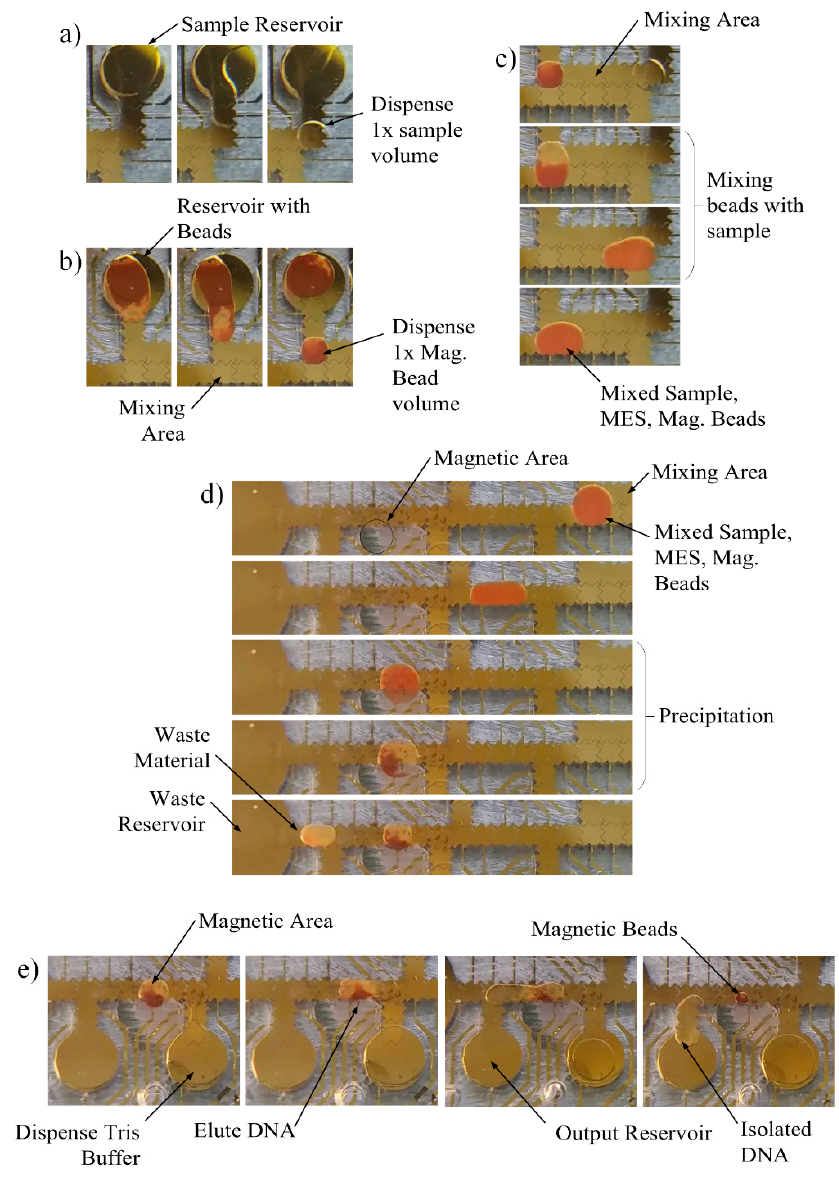
Figure 17. Bead method DNA isolation sequences. ( a ) Move sample to mix area; ( b ) Move beads and buffer to mix area; ( c ) Mix sample and beads; ( d ) Move mixture to capture area; ( e ) Elute beads and move to output.